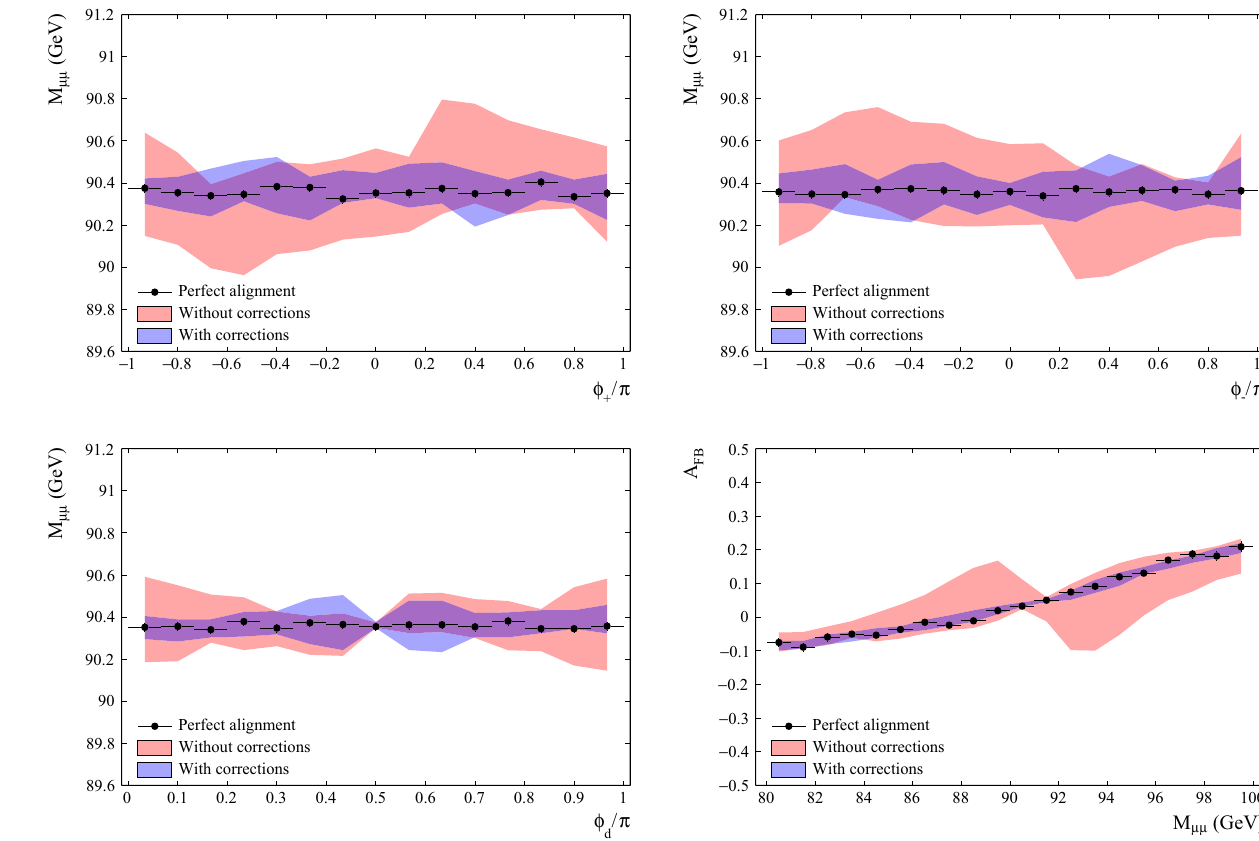
Table 1 The biases in the values of m W + , m W − and sin 2 θ eff correspondingshifts in the minimum χ 2 values, that are caused by the